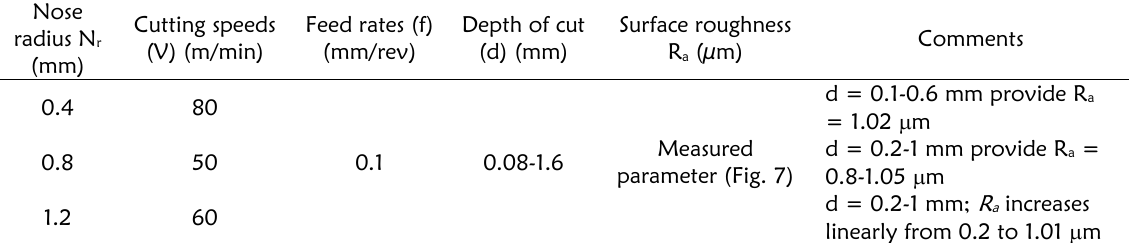
Table 3: Operational data for feed rate